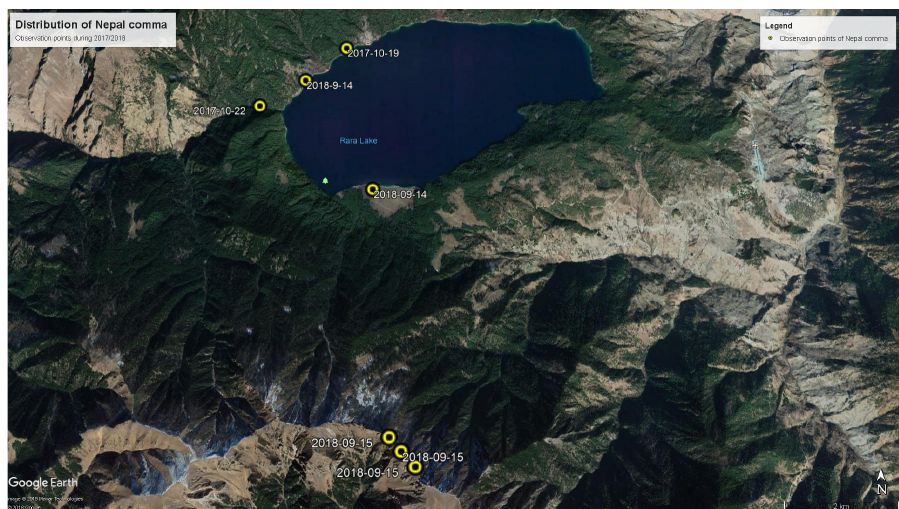
Figure 1. Observation locations of Nepal Comma Polygonium c-album agnicula during 2017-2018.